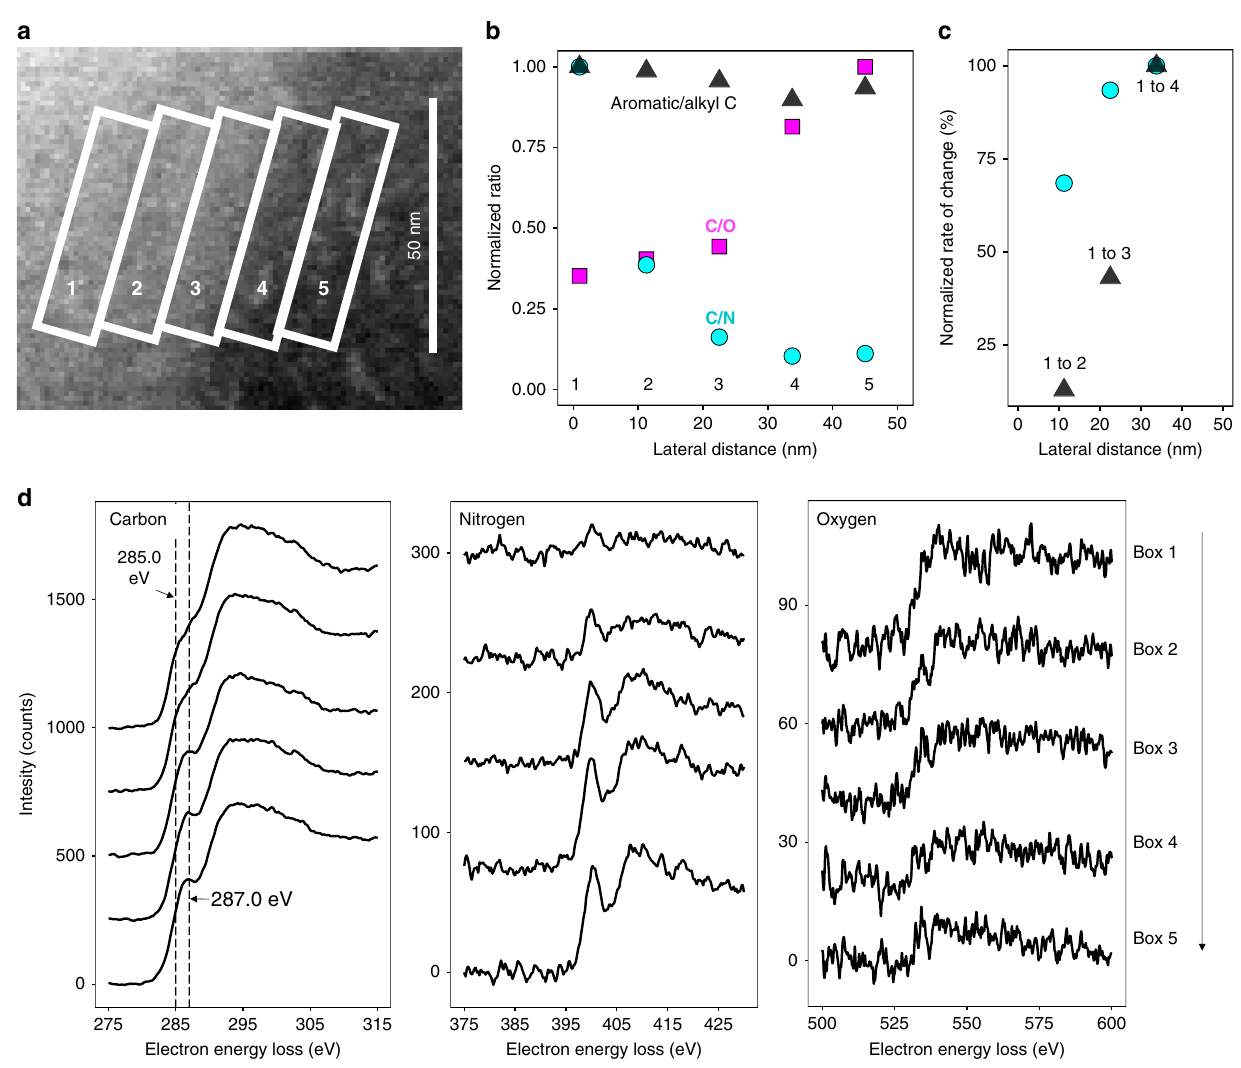
Fig. 4 Gradient in organic composition across the organo – organic interface. Distinct combinations of carbon/nitrogen (C/N), carbon/oxygen (C/O), and aromatic/alkyl C ratio across the organo – organic interface shows a gradient of organic matter (OM) composition at the ~50 nm scale. a Annular dark- fi eld (ADF) scanning transmission electron microscopy (STEM) detail of the interface between organic phases in a soil thin section. Boxes 1 through 5 indicate regions used to compute average electron energy-loss (EEL) spectra across the interface (lateral distance). b Ratios of normalized (maximum = 1 unit) elemental integrated area for C/N, C/O, and aromatic/alkyl C across the interface. The aromatic/alkyl C ratio is the ratio of integrated intensity in EELS spectral regions (de fi ned here as aromatic from 284.25 to 285.75 eV and alkyl from 286.0 to 287.5eV) normalized to total C integrated area (280.0 – 315.0 eV). Each location (1 – 5) across the interface shows a different combination of C/N, C/O, and aromatic/alkyl C. At point 4, alkyl C is enriched relative to the high-alkyl C matrix. The calculations for each point are from ~540 individual spectra (1 spectrum per pixel) in each 11 × 44 nm box. c Rate of change for C/N and aromatic/alkyl ratios across the organo – organic interface relative to box 1. The C/N ratio decreases more rapidly than the aromatic/ alkyl ratio for the transitions from boxes 1 to 2 and 1 to 3, which suggests trends in C composition and N quantity are decoupled across the interface. d Average EEL spectra (spline curve, an average of ~540 individual spectra) for boxes 1 – 5 for the carbon, nitrogen, and oxygen K-edges. Carbon K-edge EELS show similar intensity but a change in fi ne structure. For carbon, vertical lines at 285.0 and 287.0 eV are putatively associated with aromatic and alkyl C, respectively. Nitrogen and oxygen K-edge EELS show an increase and decrease in intensity across the interface,